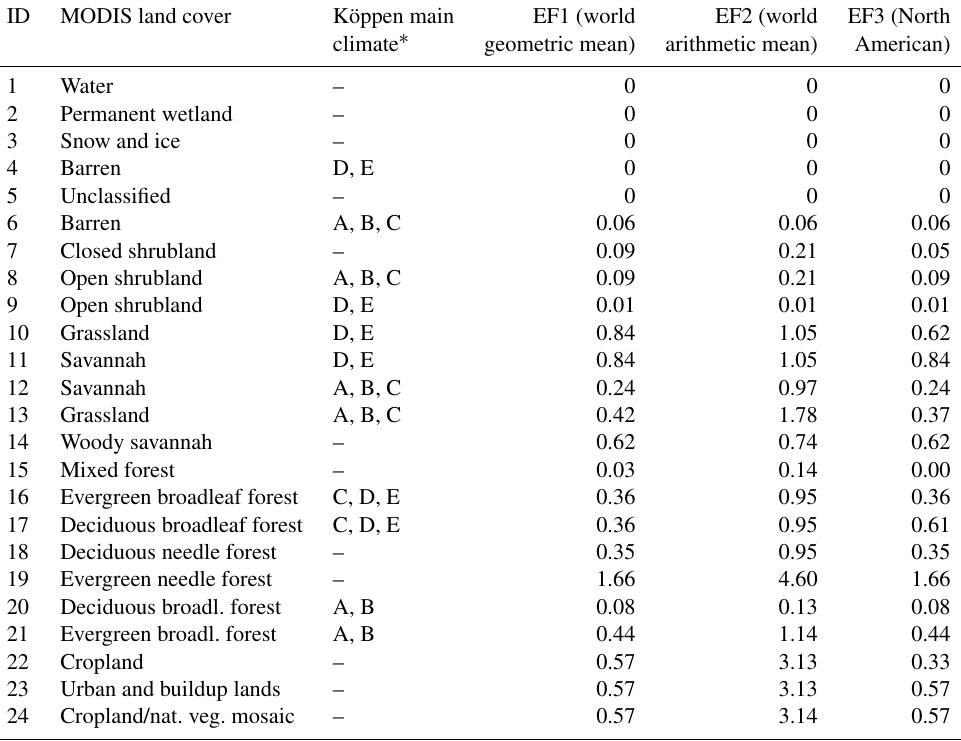
Table A1. List of 24 soil biome emission factors (EFs) from Steinkamp and Lawrence